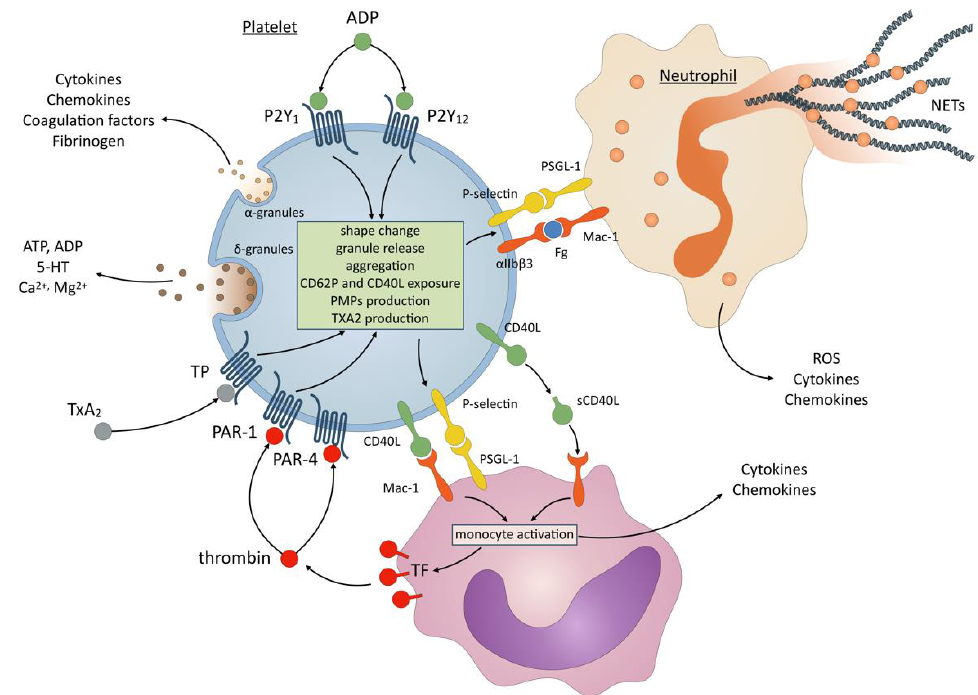
Figure 2. Schematic overview of the role of platelet P2Y 12 activation in inflammation. ADP binding to P2Y 12 initiates platelet activation and amplifies granule secretion and aggregation induced by ADP-mediated P2Y 1 stimulation and by strong agonists such as thrombin (PAR-1 and PAR-4 receptors) and TXA 2 (TP receptor). Activated platelets release alpha and dense granules contents, including cytokines, chemokines, coagulation factors and platelet agonists. Cytokines, chemokines and soluble CD40 ligand (sCD40L) can recruit and activate leukocytes, especially neutrophils and monocytes. Expression of P-selectin and CD40L at the surface of activated platelets allow interaction between platelets and leukocytes which is a critical step in platelet-mediated inflammation. P-selectin cross-links platelets and leukocytes through its corresponding ligand P-selectin glycoprotein ligand-1 (PSGL-1) present on monocytes and neutrophils. Platelet-leukocyte aggregates are further stabilized by numerous additional receptor / ligand pairs, especially leukocyte Mac-1 that recognizes platelet CD40L and fibrinogen (Fg) bound to platelet α IIb β 3. Activation by platelet interaction or soluble mediators stimulates monocyte cytokine and chemokine production, expression of tissue factor and thrombin generation. Platelet-bound neutrophils produce inflammatory mediators including reactive oxygen species (ROS), and release neutrophil extracellular traps (NETs) that play a critical role in many inflammatory conditions, especially sepsis-induced organ injuries, autoimmunity, tumorigenesis and